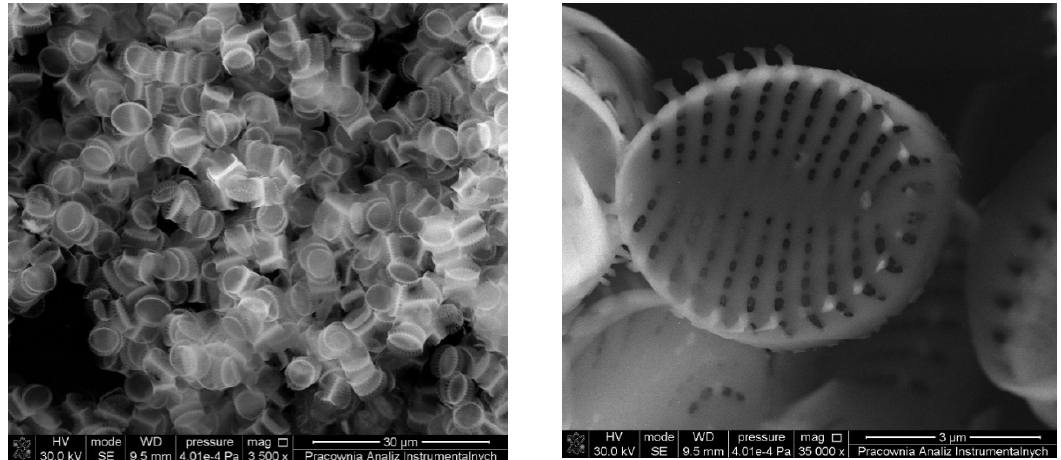
Figure 1. SEM images of the diatomaceous biosilica.